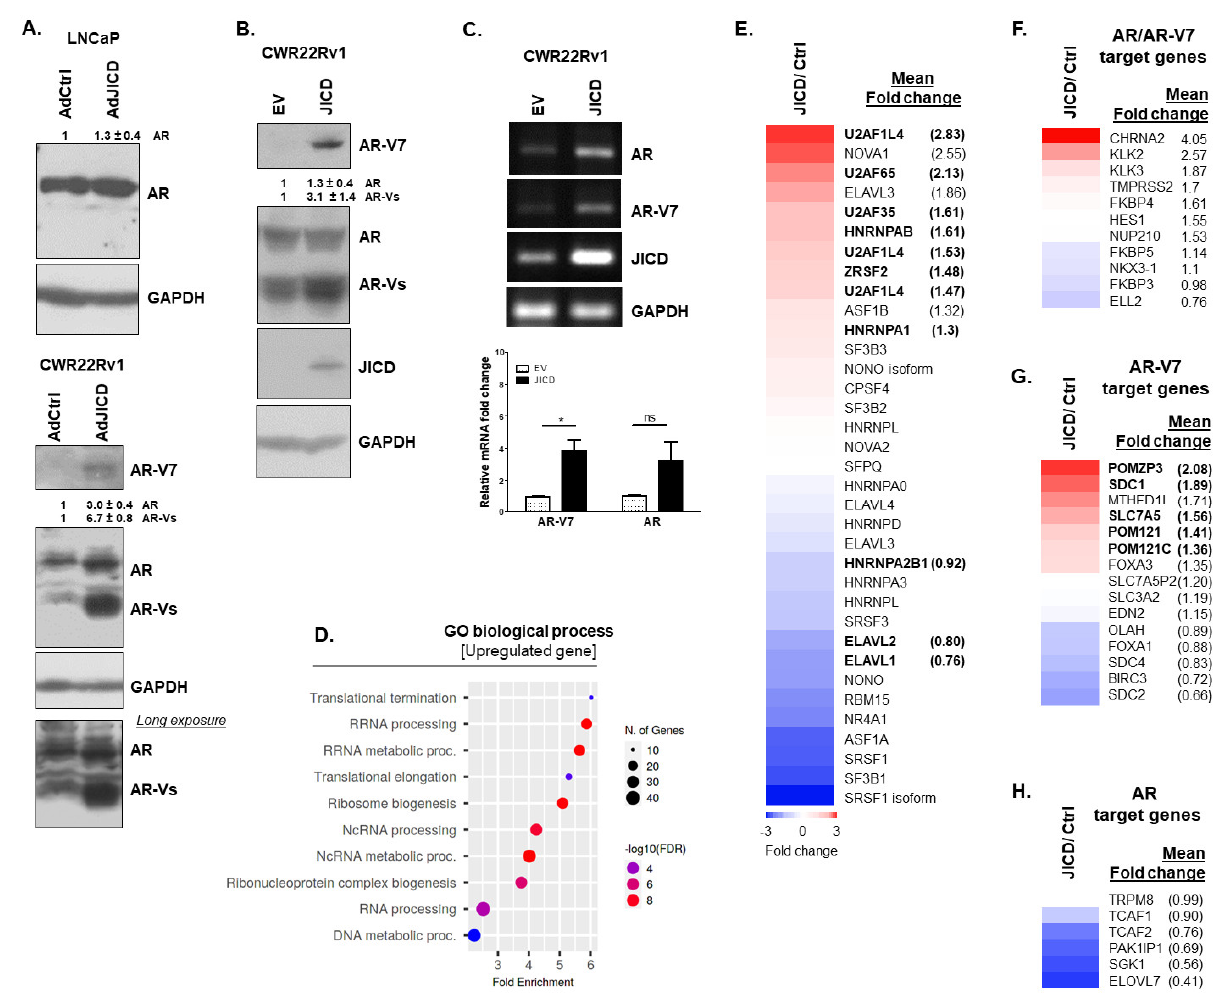
Figure 2. Processed intracellular domain of JAG1 (JICD) increases the expression of AR-Vs. ( A ) Representative Western blot analysis showing the increased protein levels of AR and AR–Vs in AdJICD–infected LNCaP and CWR22Rv1 cells compared to AdCtrl–infected cells. The proteins of AR and ARs including AR–V7 were detected using mouse anti-AR (sc–7305, Santa Cruz) and rabbit anti-AR–V7 (68492, Cell Signaling, Danvers, MA, USA) antibodies. ( B , C ) Stable JICD–overexpressing CWR22Rv1 subline cells show the increased expression of ARs, including AR–V7, at protein ( B ) and mRNA ( C ) levels. Representative RT–PCR ( top ) and quantitative RT–PCR (qPCR; bottom ) analysis of three independent experiments ( C ) revealing a significant increase of AR–V7 mRNA expression in stable JICD–overexpressing CWR22Rv1 subline cells. GAPDH was used as a loading control. Data are shown as mean ± SEM, three independent experiments. *, p < 0.01; ns, not significant; two–tailed t –test. ( D ) JICD overexpression enriches the expression of genes involved in RNA processing and metabolic process, RNP complex biogenesis, and DNA metabolic process. ( E ) JICD upregulates the expression of some splicing factors involved in the generation of AR–V7 in CWR22Rv1 cells. ( F – H ) JICD overexpression enhances the expression of some shared AR/AR–V7 ( F ) and AR–V7 target genes ( G ) and negatively affects the expression of most AR target genes ( H ). False discovery rate (FDR) < 0.05. Values above Western blots indicate the relative band intensity of each protein normalized to GAPDH and are shown as mean ± SD, which were obtained by densitometrical quantification of at least three independent experiments. All uncropped Western blot and gel original images are shown in Figure S7.